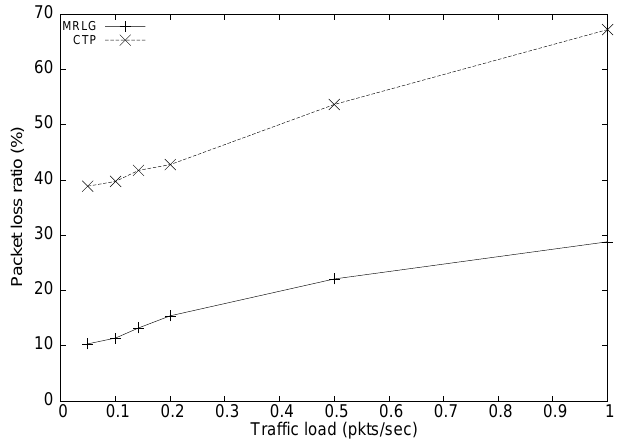
Figure 7. Packet loss ratio when varying load.